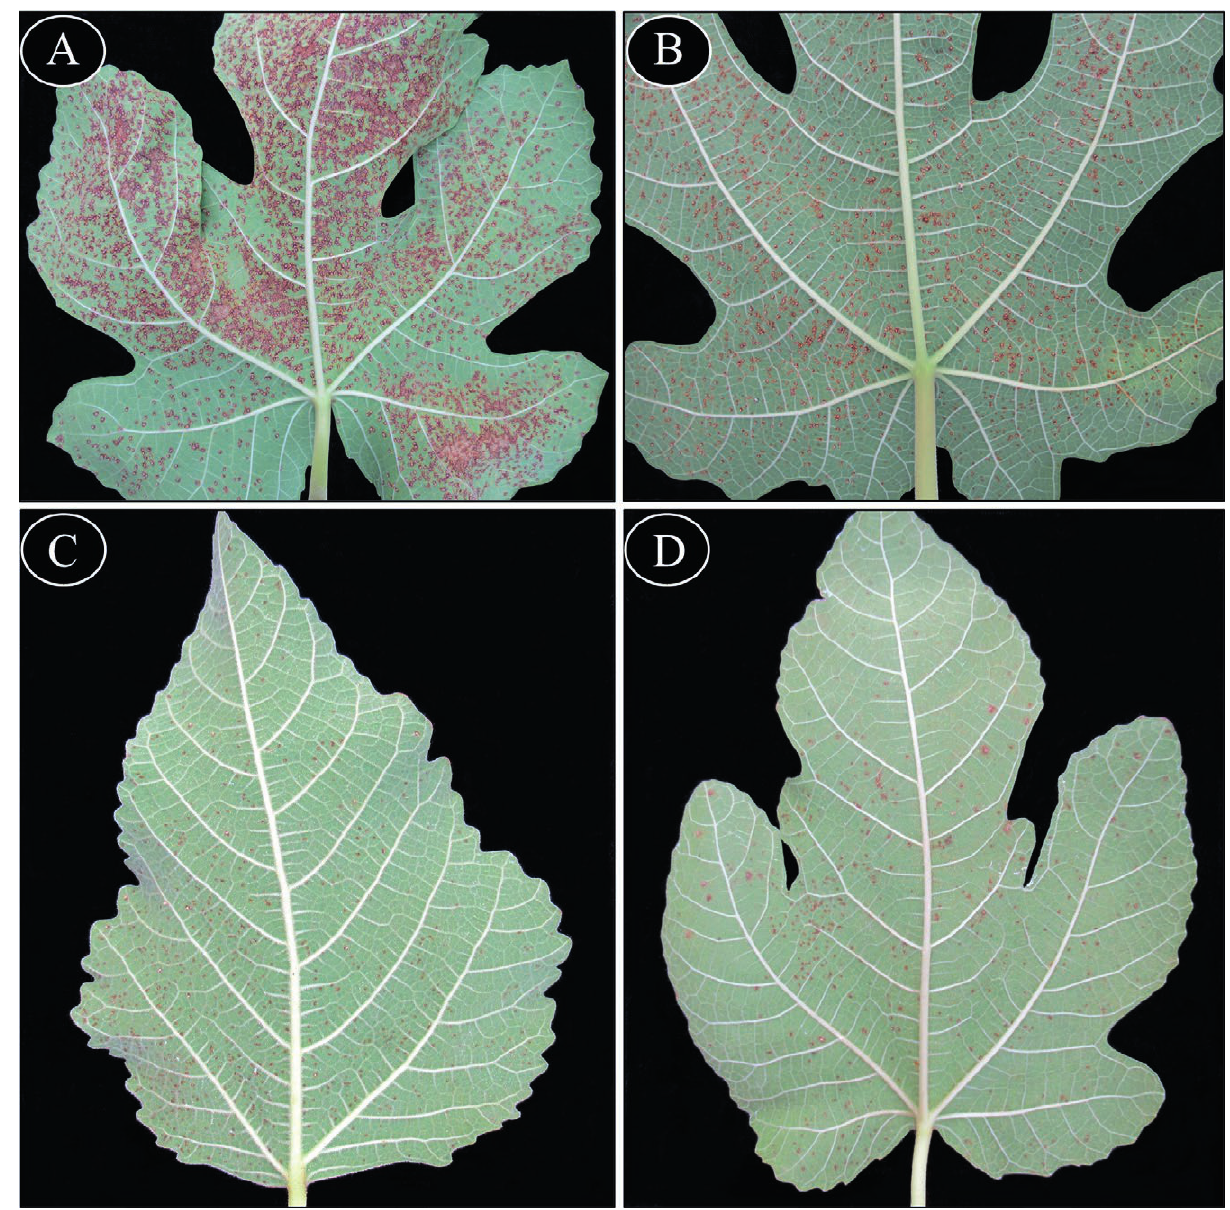
Figure 6. Fig rust symptoms on the abaxial surfaces of leaves from the fig cultivars Noire de Caromb (A), Brunswick (B), Adamsvy (C) and Black Genoa (D), 27 d post inoculation with urediniospores of Phakopsora nishidana